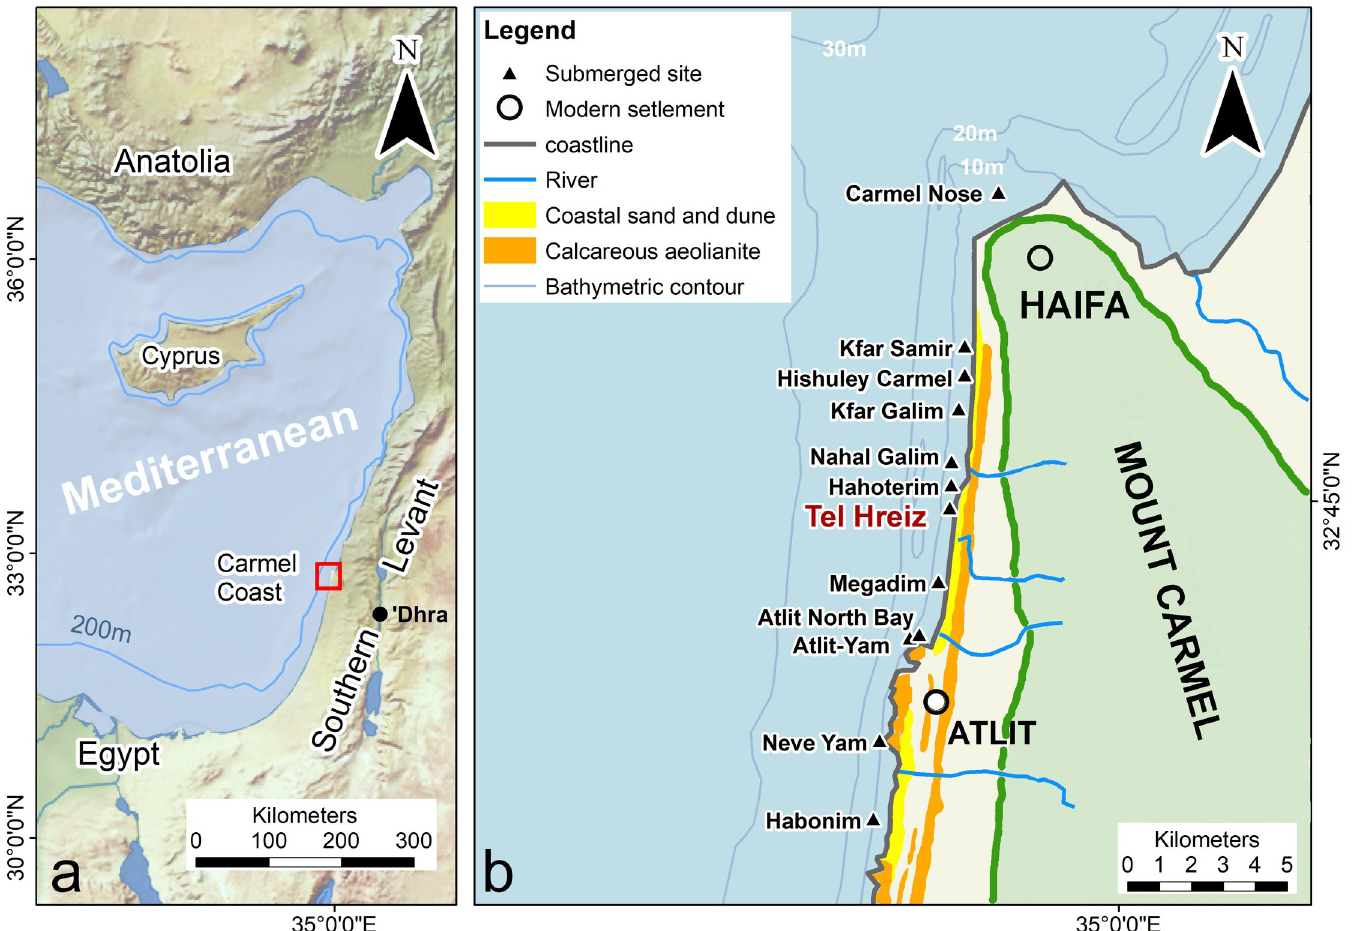
Fig 1. Location maps. (a) Eastern Mediterranean and the Israeli coast; (b) submerged Neolithic settlements off the Carmel coast (drawing J. McCarthy after Galili et al. 2019, modified after Natural Earth ( https://www.naturalearthdata.com in the public